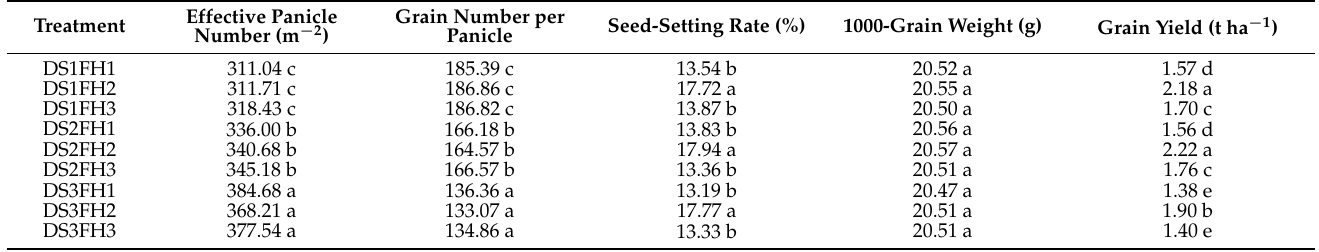
Table 2. Effects of different planting densities and flight heights on hybrid rice seed production in